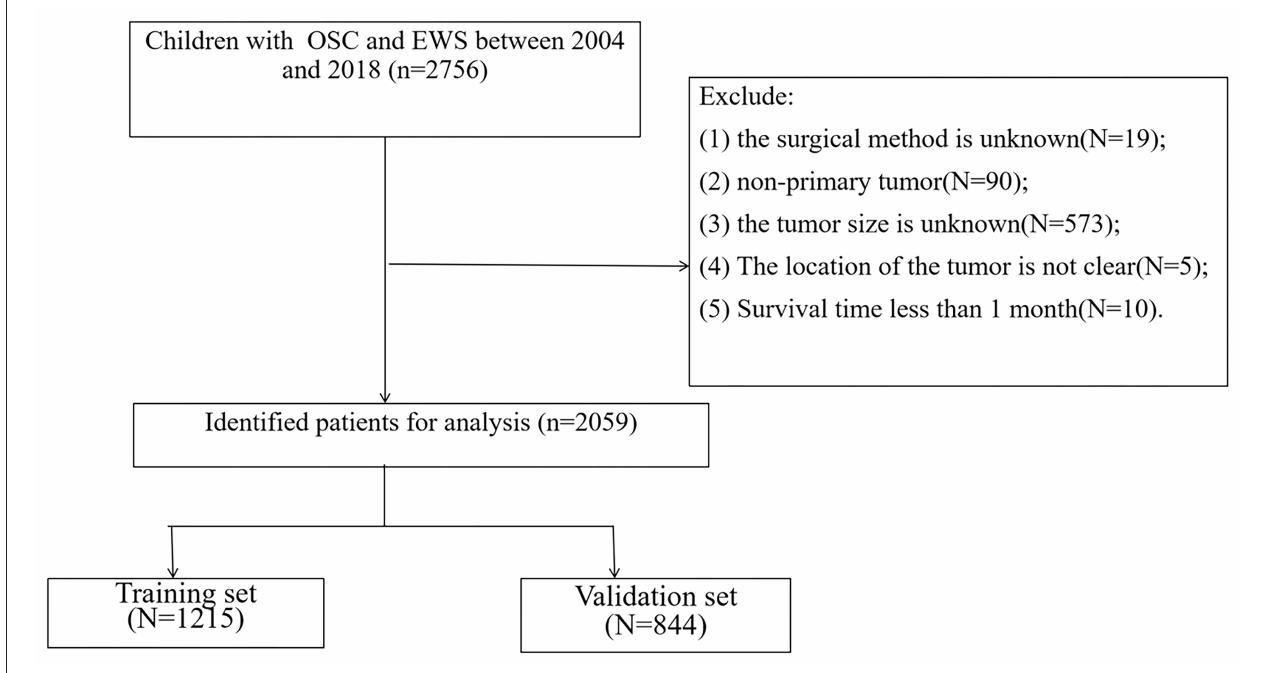
FIGURE 1 | The flowchart of including and dividing patients.